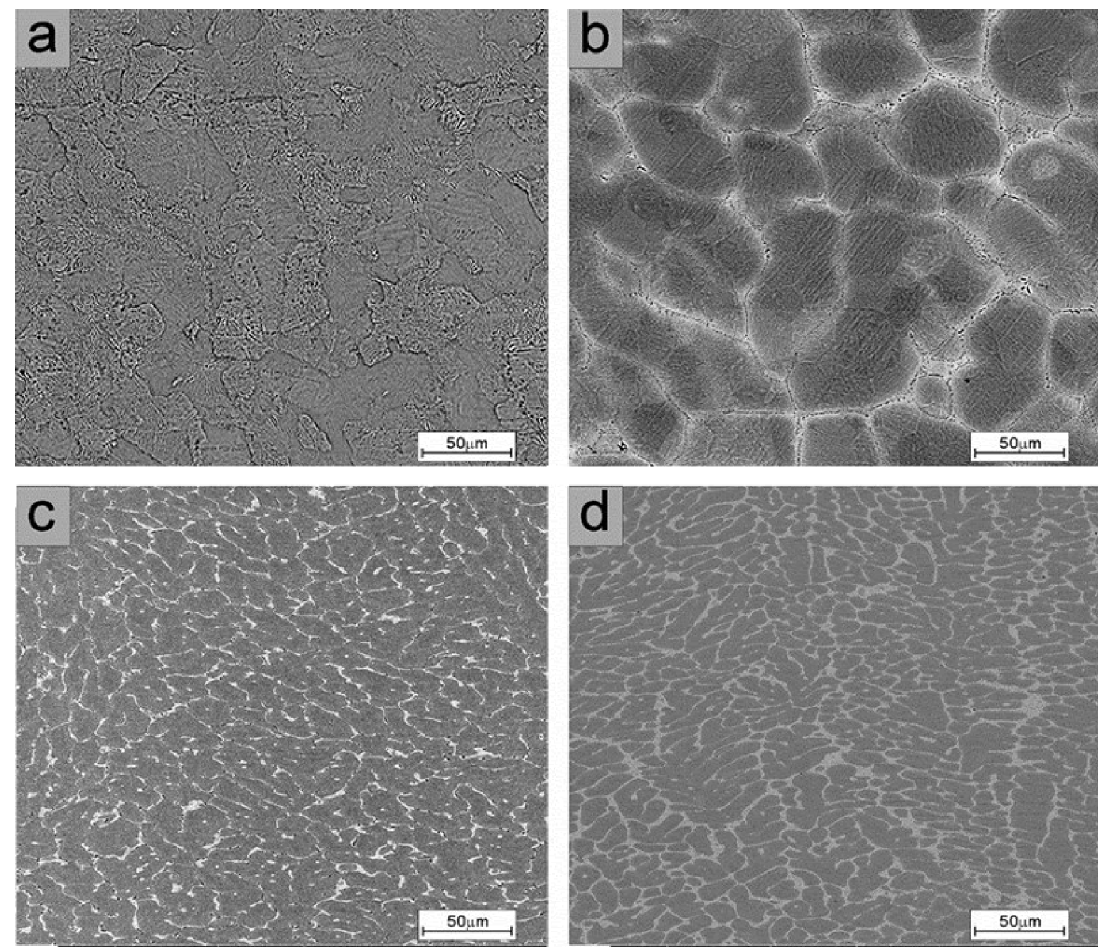
Figure 1. SEM micrographs of the solution annealing treated alloys (a) NiTi, (b) NiTi3Nb, (c) NiTi6Nb and (d) NiTi9Nb.